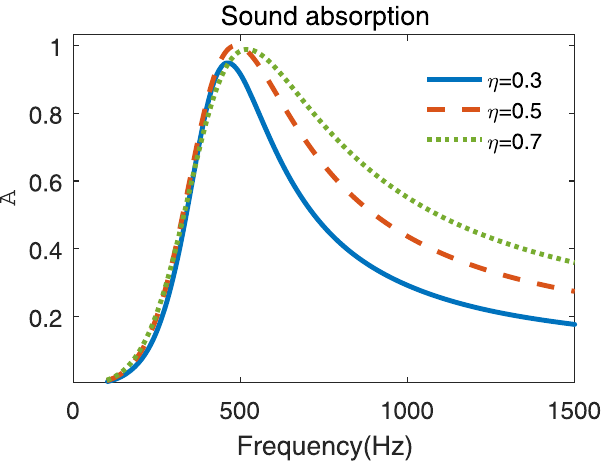
Figure 4. Sound absorption coefficients of the inverse designed metasurface with imperfect modulus loss